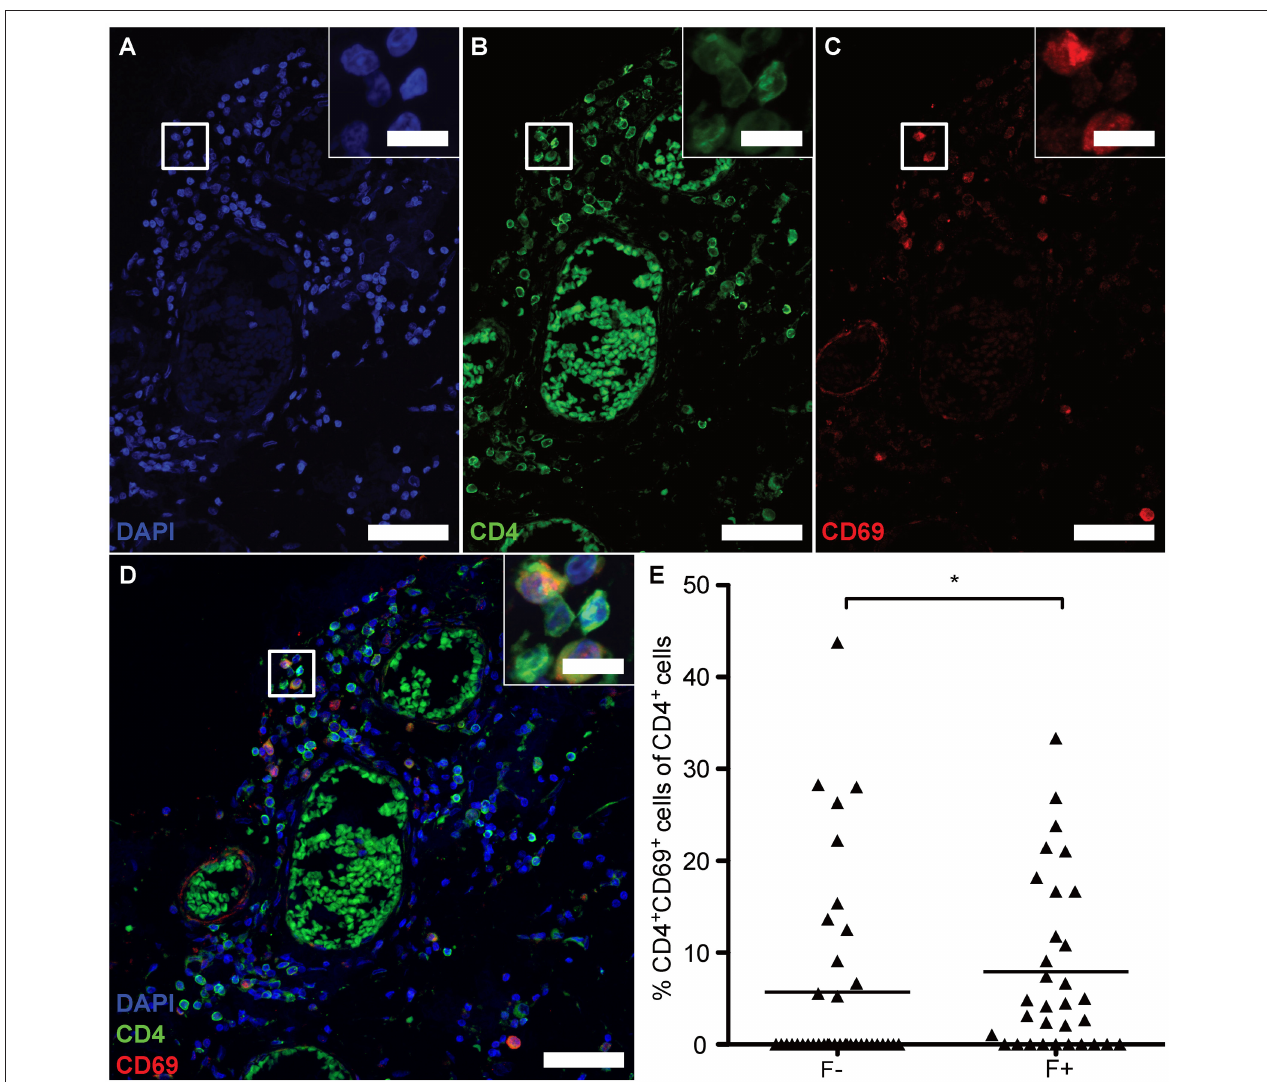
FIGURE 8 | eLFs of brain and spinal cord exhibit more CD4 + CD69 + cells. (A–D) Consecutive IF co-staining of CD4 and CD69 in follicle-like structures of SPMS brains and spinal cords. Inserts show co-localization of CD4 + cells with CD69 suggesting tissue-resident T cells in a representative meningeal eLF of SPMS spinal cord (same region as Figures 3 , 4E–H , 5 ). Scale bar indicate 100 µ m, scale bars of the inserts indicate 10 µ m. (E) Percentage of tissue-resident cells defined as CD4 + CD69 + cells of CD4 + cells in follicle-like structures (F + ) and less defined infiltrates (F-) in SPMS brains and spinal cords. F-, 5.70, SD = 10.67, n = 38; F + , M = 7.92, SD = 9.39, n = 32; Mann Whitney test, U = 434.0, p =